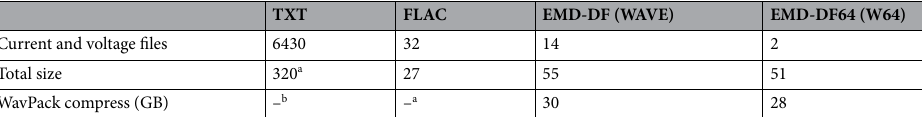
Table 5. Comparison of file formats using BLUED as a reference dataset. a 54 GB when compressed using RAR (see https:// www. rarlab. com/). b Not